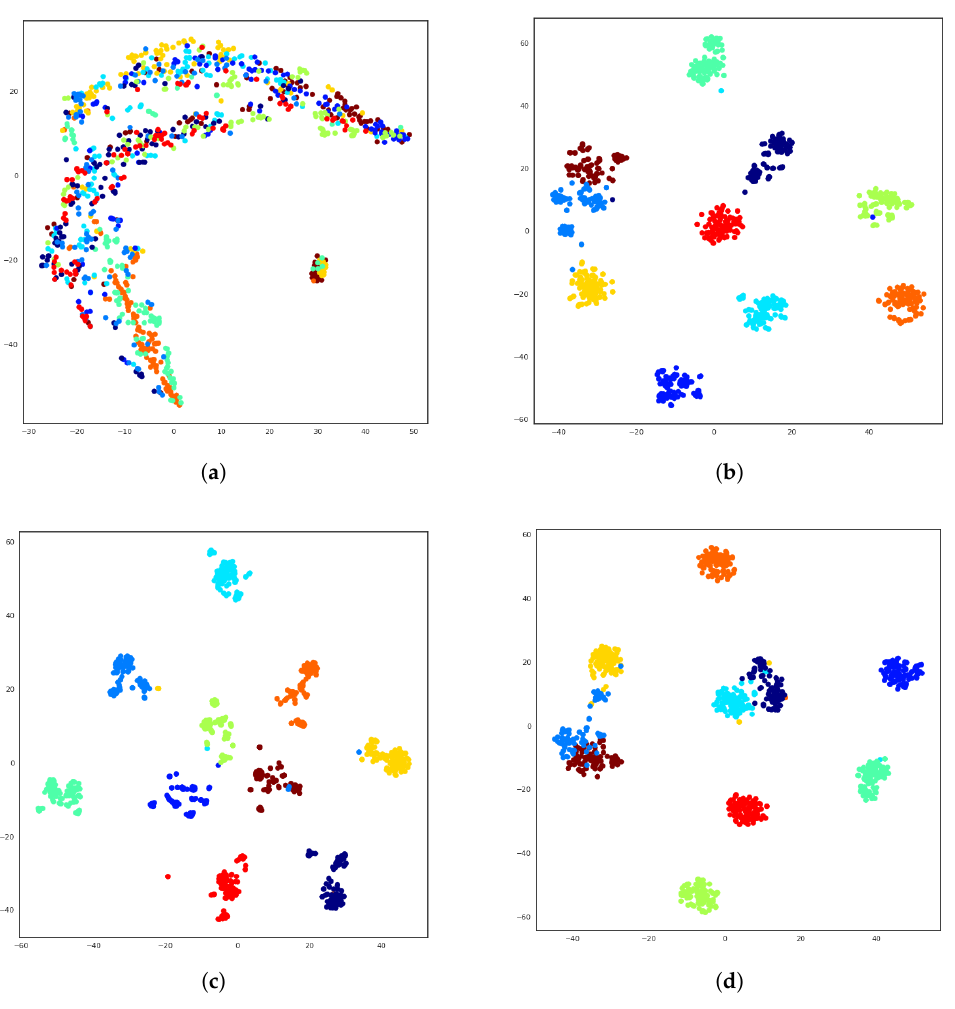
Figure 5. t-Distributed Stochastic Neighbor Embedding (t-SNE) [65] visualization of the TestSet1000 in the latent embedding space. Different colors denotes samples belonging to different classes. ( a ) Randomly initialized; ( b ) Trained for classification; ( c ) Trained for multi-label; ( d ) Trained for